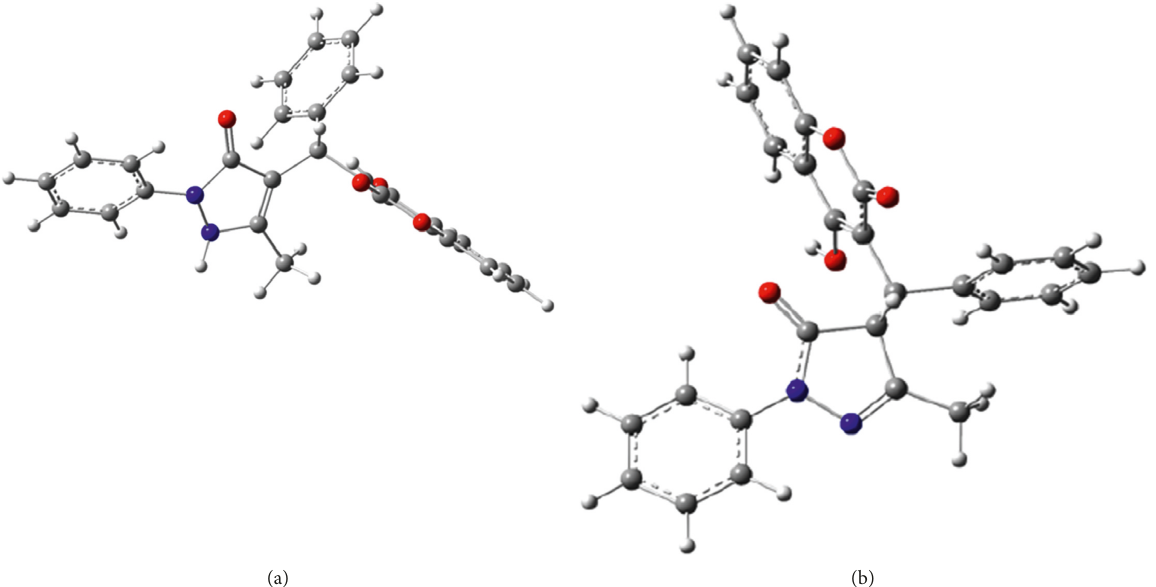
Figure 2: Optimized 3D geometrical structures for compounds (a) A and (b) B